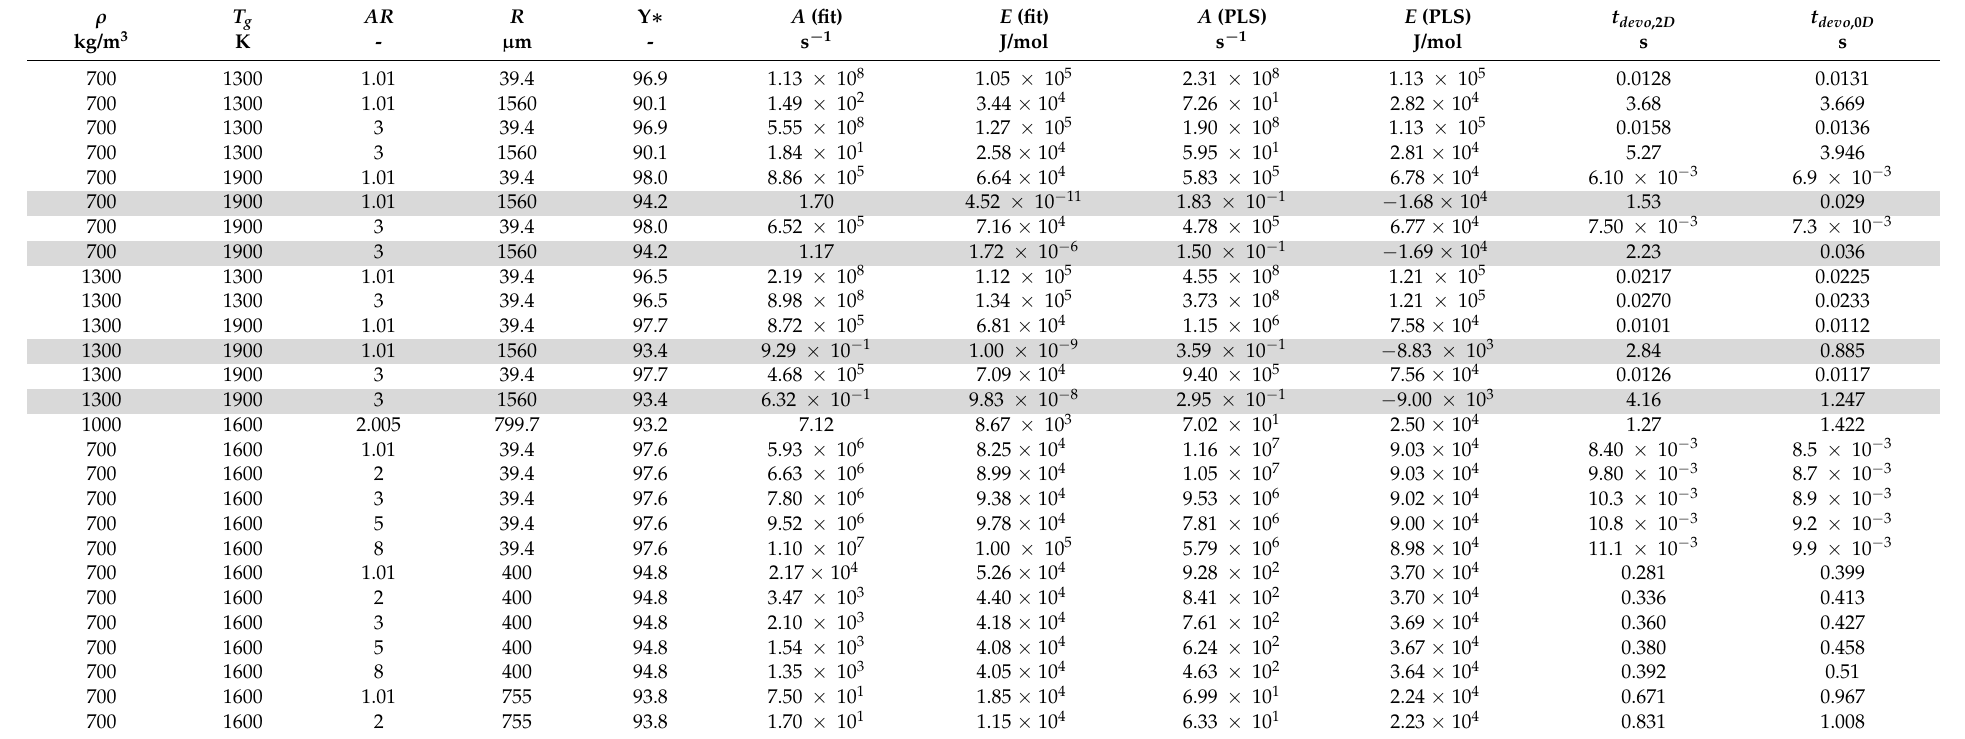
Table A1. Model input and output parameters. Cases with negative E values marked in